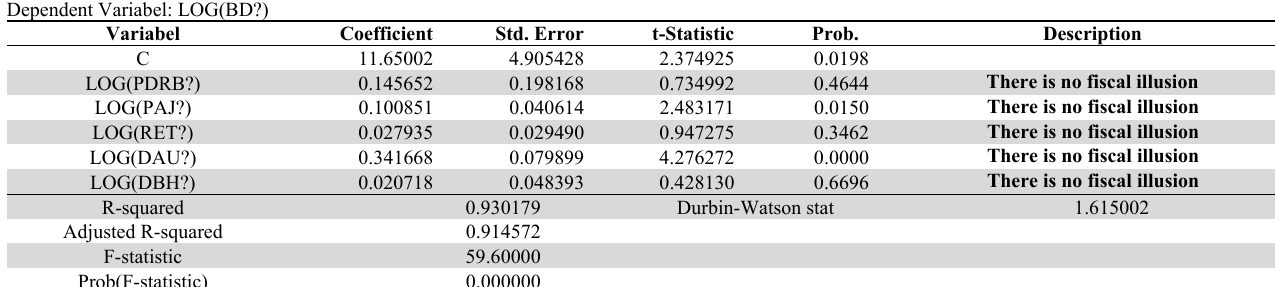
Equation Statistical Test Results (1) Model